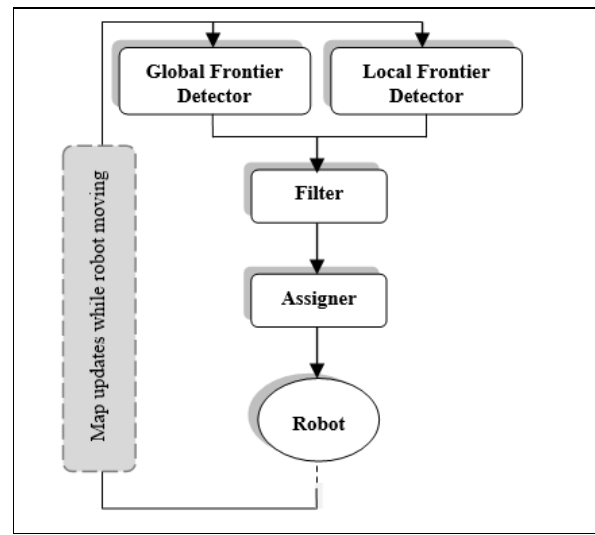
Figure 9. Connection between RRT package's nodes (Umari & Mukhopadhyay, 2017)